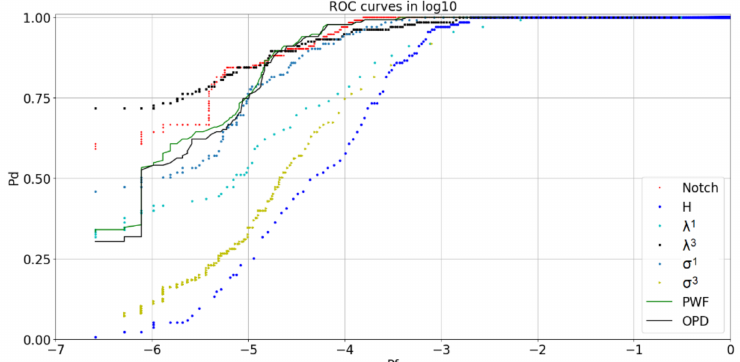
σ σ 1 and 3 are from the